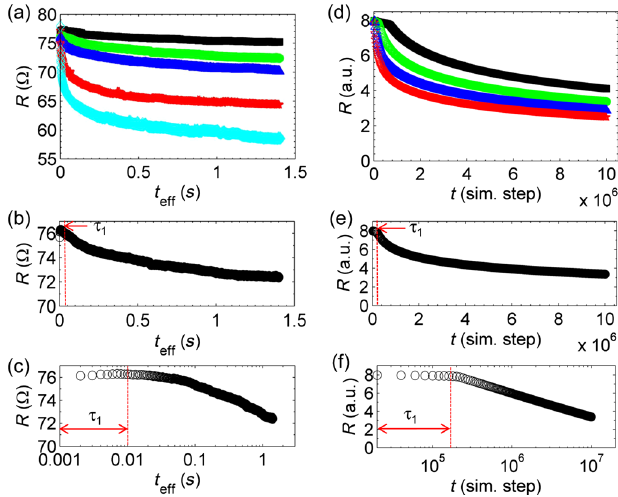
FIG. 4. Time dependence of the resistive change R ð t Þ for various external current intensities. Top left: Experimental data measured on an Ag = LPCMO = Ag memristor with I ¼ 37 . 5 mA (black), 40 mA (green), 50 mA (blue), 80 mA (red), and 100 mA (cyan). Here, t is the effective time duration of the applied eff currents (see Appendix F for details). The initial state was reset by applying an intense negative polarity current of 350 mA. Note that the initial value of the resistance, 78 Ω , is recovered within (cid:3) 1 Ω . Top right: Model simulations with applied current: I ½ a : u : (cid:2) ¼ 58 . 5 (black), 71.5 (green), 84.5 (blue), and 97.5 (red). Middle panels: Experimental data for I ¼ 40 mA (left) and simulations for I ½ a : u : (cid:2) ¼ 71 . 5 (right). Here, τ 1 is defined as the time interval from the beginning of the applied pulse until the resistance starts to drop. Bottom panels: Idem as middle panels in a semilog